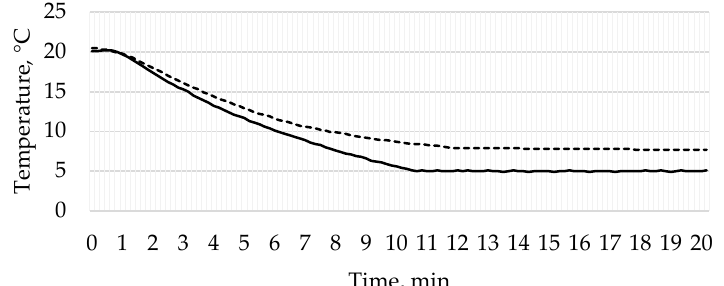
Figure 5. Temperature changes over time inside the reactor.